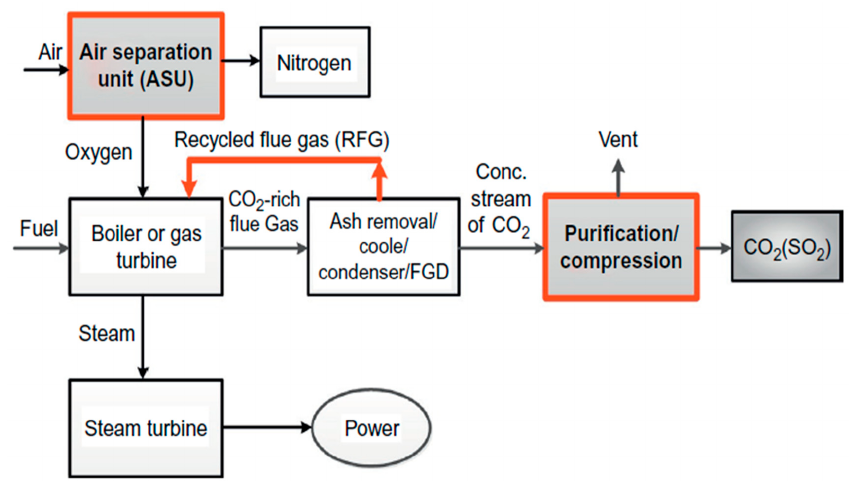
Figure 11. Flowsheet of oxy fuel combustion technology for power generation with CO 2 capture [5].